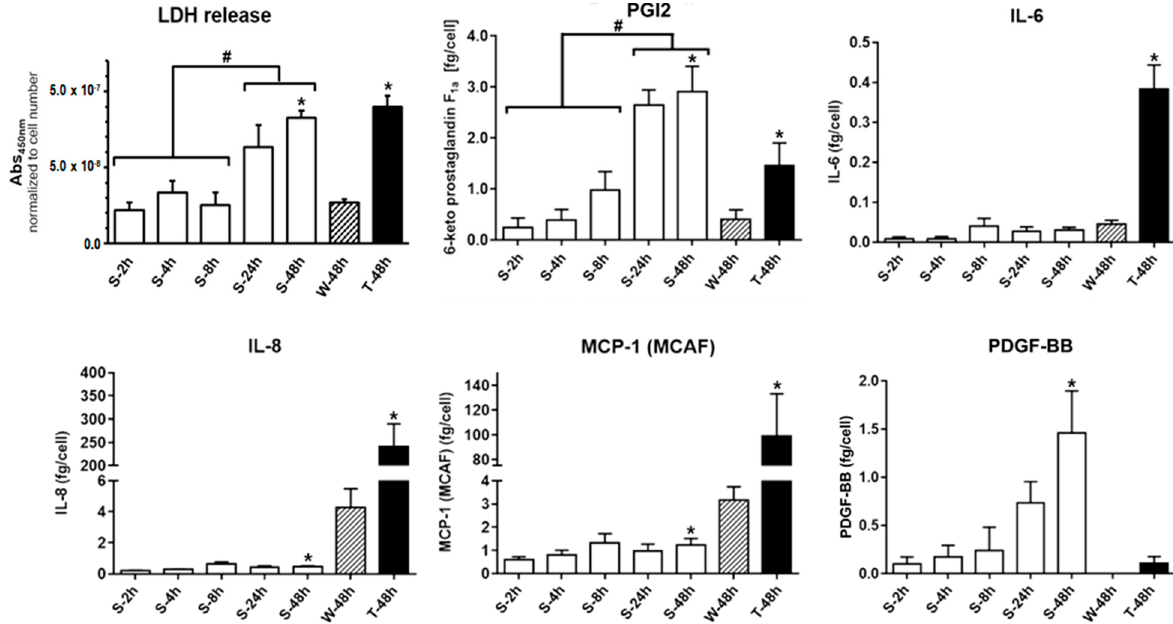
Figure 6. Secretion profile of nonadherent HUVEC. Nonadherent HUVEC release of LDH and various inflammatory mediators, cytokines and growth factors per cell detected in the HUVEC culture medium during cultivation period. Data shown as arithmetic mean ± standard deviation; * p compared to growth control on TCP (W-48h); # p compared in between nonadherent HUVEC; n = 6 from two independent experimental series with n = 3 HUVEC seedings each.